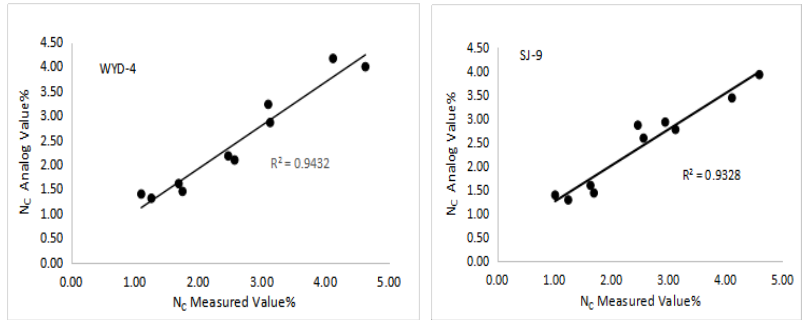
Figure 6. Calibration N c dilution curve of leaf dry matter of rice (r 0.01 = 0.765).The data of N120 and N180 were selected for verfication.